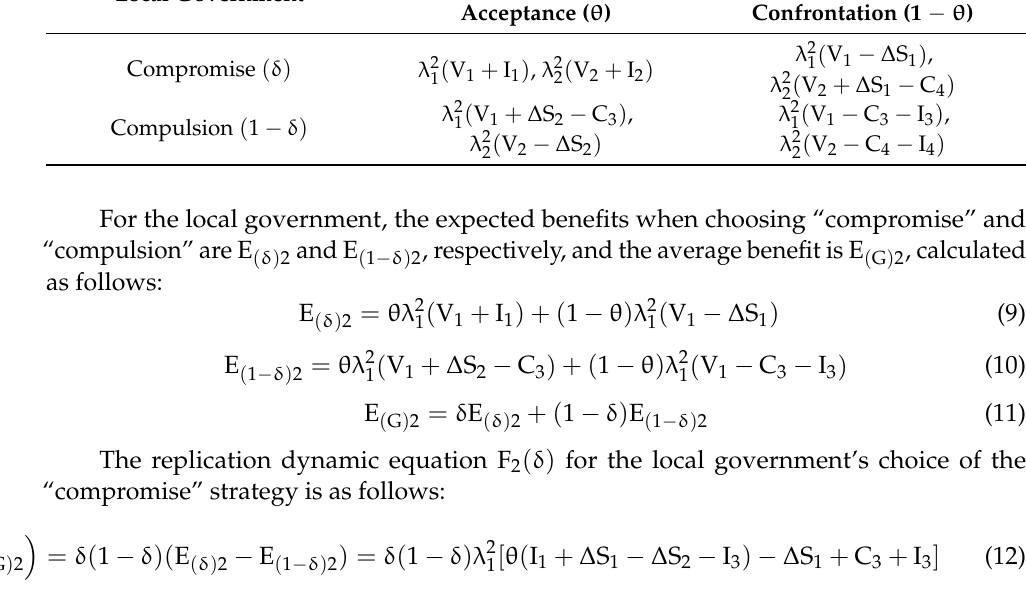
Table 2. Game payment matrix under nonlitigation settlement. Local